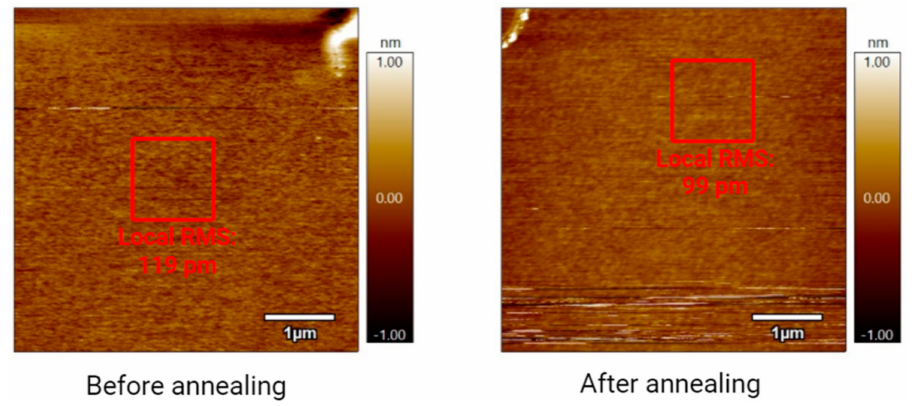
Figure 11. AFM analyses of Y 2 O 3 films before and after